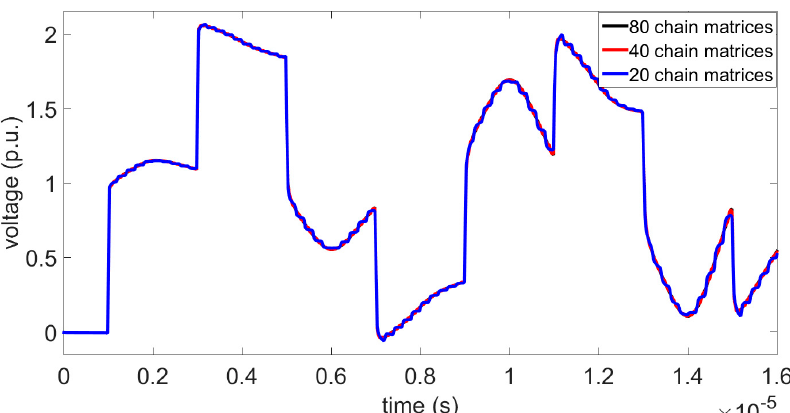
Figure 9. Comparison of transient voltage waveforms at the middle point of the line computed with different numbers of chain matrices. The curve computed with 20 chain matrices is not as smooth as the ones computed with 40 and 80.